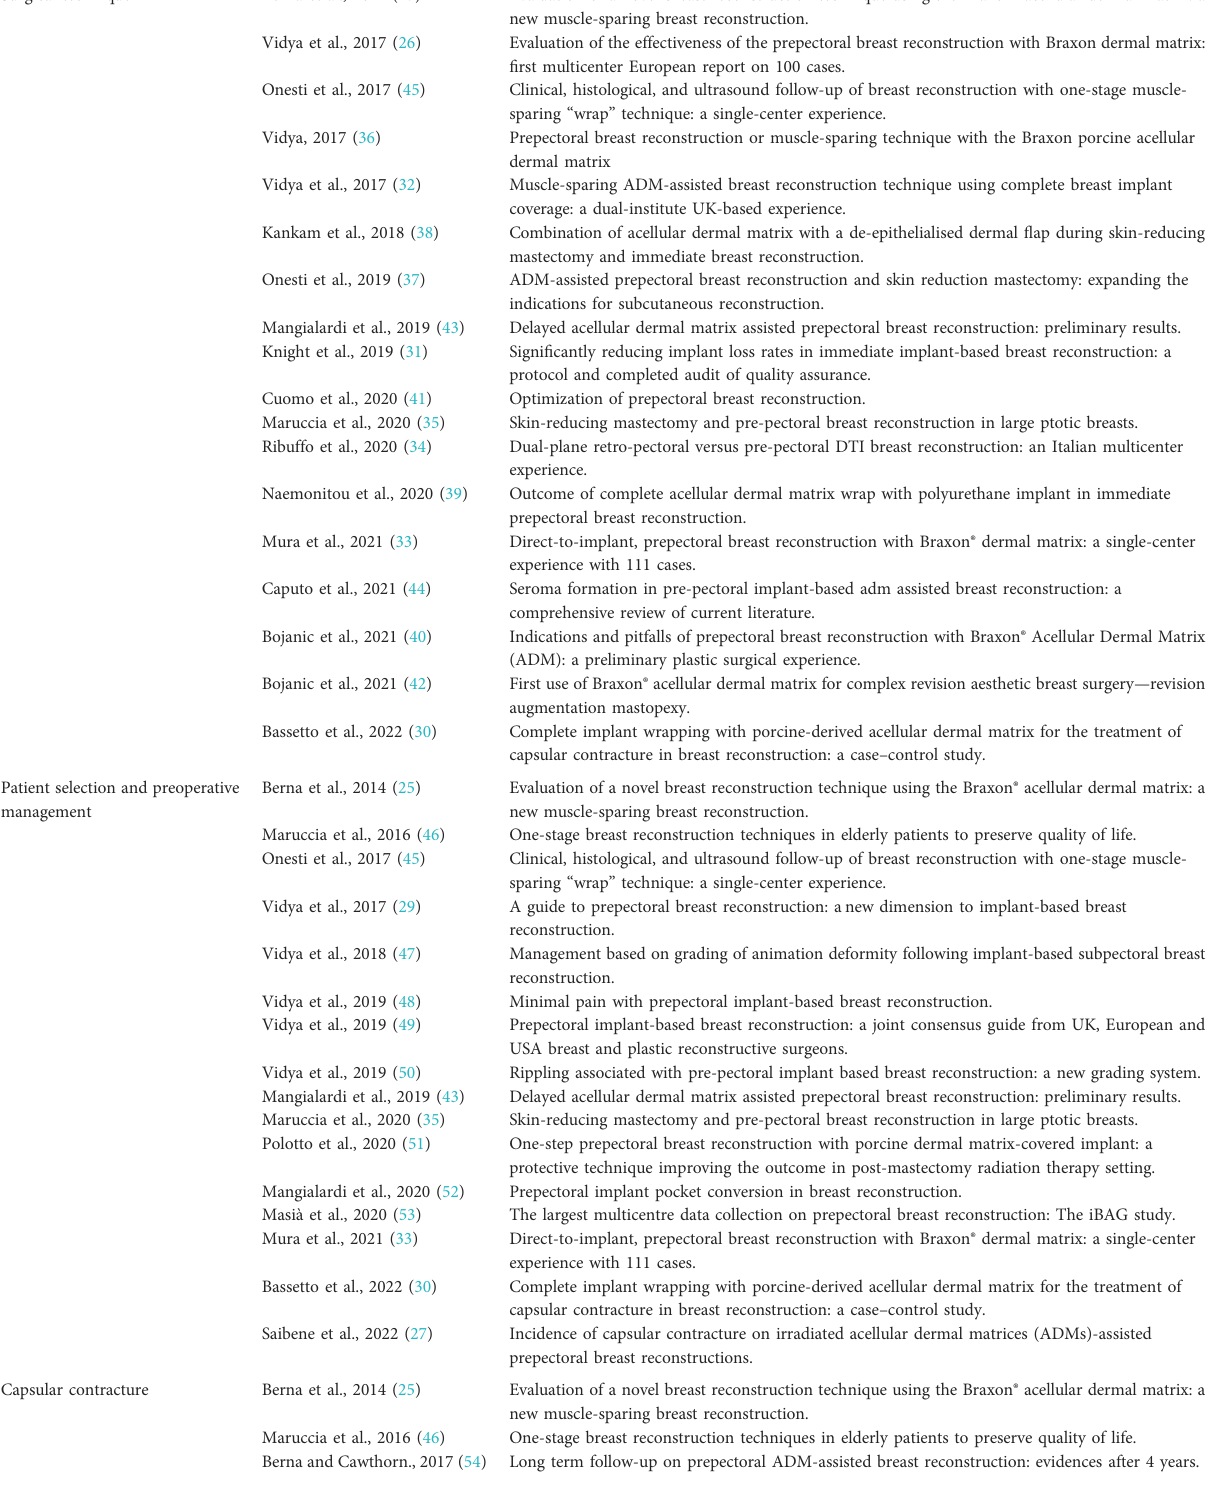
TABLE 2 List of the Braxon®-speci fi c published articles subdivided by topics.